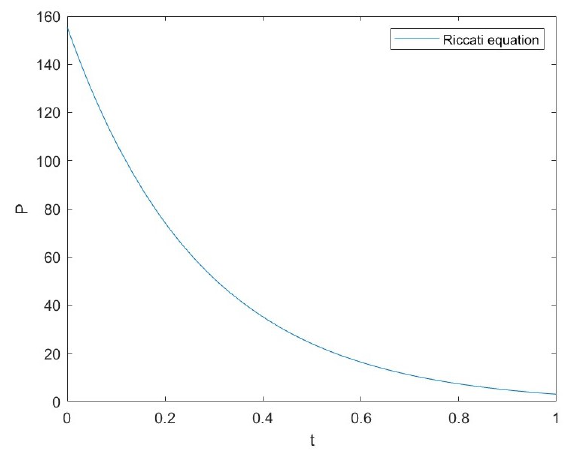
Figure 2. Riccati